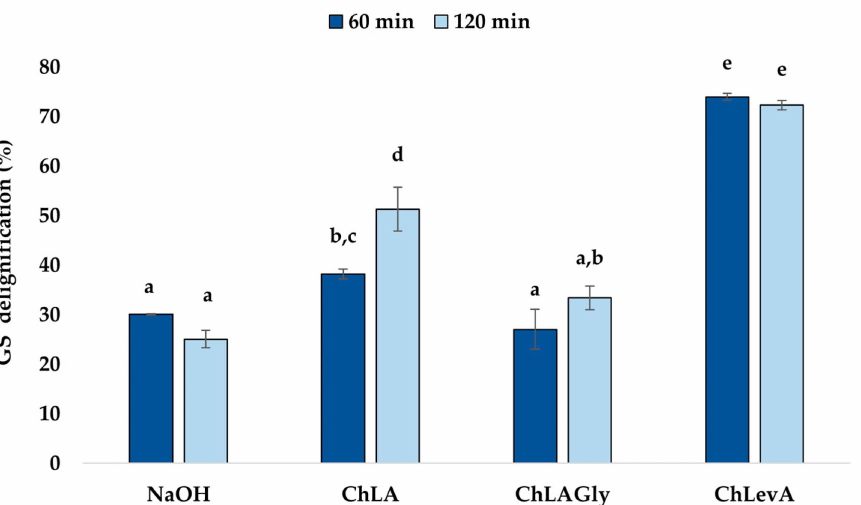
Figure 1. Grape stalk (GS) delignification by alkaline and NaDESs treatment under UAE (40 kHz, 200 W). Results are expressed as mean ± SD. Values within each variable with different letters are significantly different ( p <